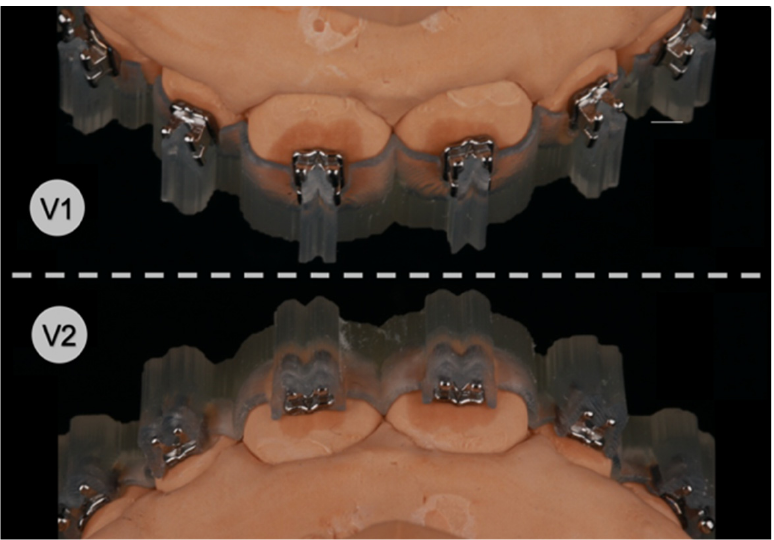
Figure 4. Both transfer tray designs with inserted brackets on stone models, version 1 ( V1 ) and version 2 ( V2